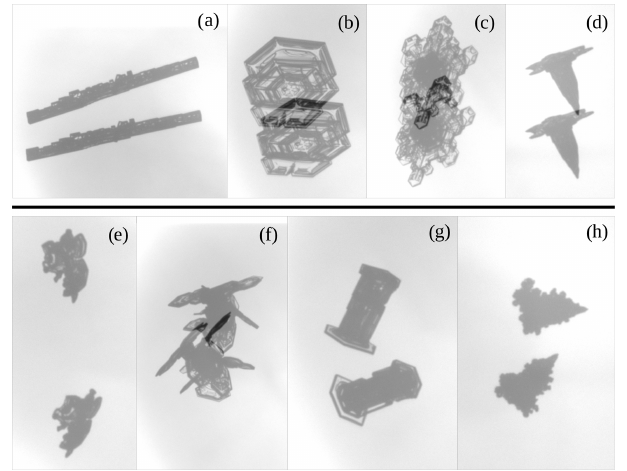
Figure 2. Panels (a) – (h) show eight examples of different parti- cles with side-view images. Panels (a) – (d) show particles that were included in the analysis. Panels (e) – (h) show particles that were ex- cluded since the two-particle exposures revealed significant tum- bling.